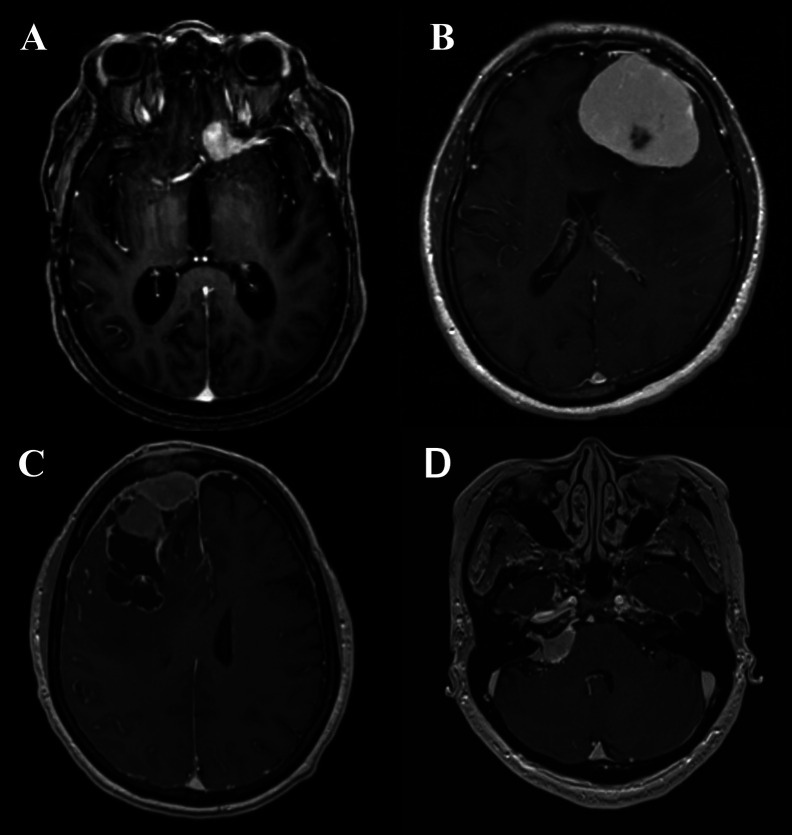

(A) Axial T1-post contrast MRI demonstrating an anterior clinoid meningioma with a characteristic dural tail. (B) Axial T1-post contrast MRI demonstrating a convexity meningioma with dural tails. (C) Axial T1-post contrast MRI demonstrating a meningioma with irregular edges abutting the superior sagittal sinus. (D) Axial T1-post contrast MRI demonstrating cerebellopontine angle meningioma.